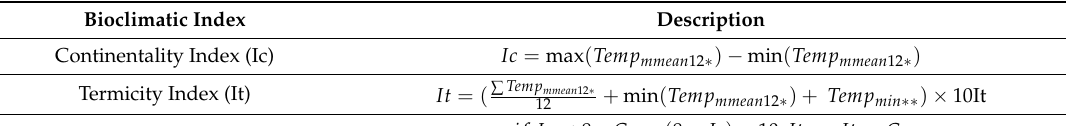
Table 1. Bioclimatic indexes’